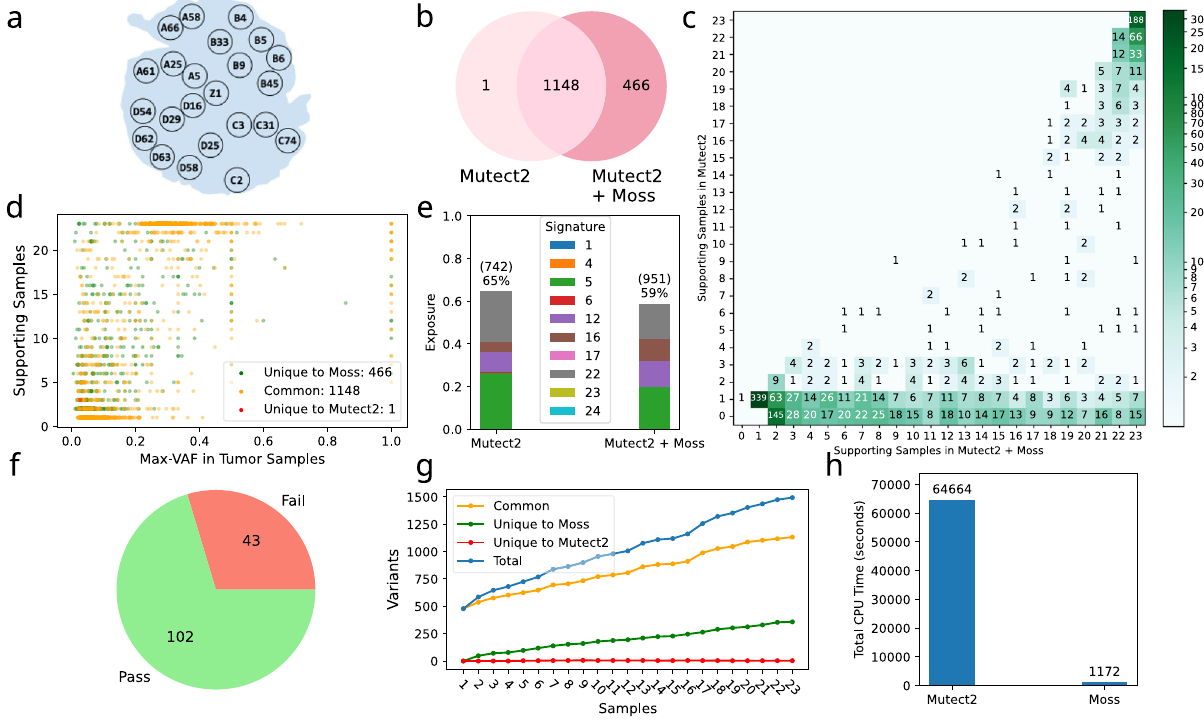
Fig. 3 Moss recovers high-quality somatic variants missed by a single-sample variant caller in a hepatocellular carcinoma (HCC) dataset 26 . a Ling et al. 26 performed whole-exome sequencing (WES) for 23 biopsies of an HCC tumor. b Venn diagram comparing the call set of Mutect2 when run in isolation and when run in conjunction with Moss. Moss identi fi es 466 new variants while retaining all variants (but one) identi fi ed by Mutect2. c The number of supporting samples identi fi ed by Moss ( x -axis) and the single-sample caller Mutect2 ( y -axis) for each variant, showing that Moss increases the number of supporting samples for 36% of variants (586 variants, spatial distribution provided in Supplementary Fig. 5). Variants uniquely recovered by Moss correspond to entries with y -axis equal to 0. d The number of samples identi fi ed by Moss to contain a variant as a function of the variant ’ s largest frequency across all tumor samples, showing that most of the variants recovered by Moss have low VAF. Color indicates whether the variant is common to Mutect2 and Moss (yellow), or unique to Moss (green) or Mutect2 (red). e Exposure to mutational signatures (indicated by color) of liver tumor for different methods. Applying Moss increases the number of variants explained by the mutational signatures (951 vs 742). f Out of the 145 SNVs newly called by Moss in exactly m = 2 samples, 102 SNVs passed the manual review (Supplementary Fig. 7). g Analyzing multiple samples simultaneously increases the number of recovered variants signi fi cantly. h Moss adds almost no overhead in run time as compared to Mutect2. Similar results are observed for Strelka2 (Supplementary Fig.